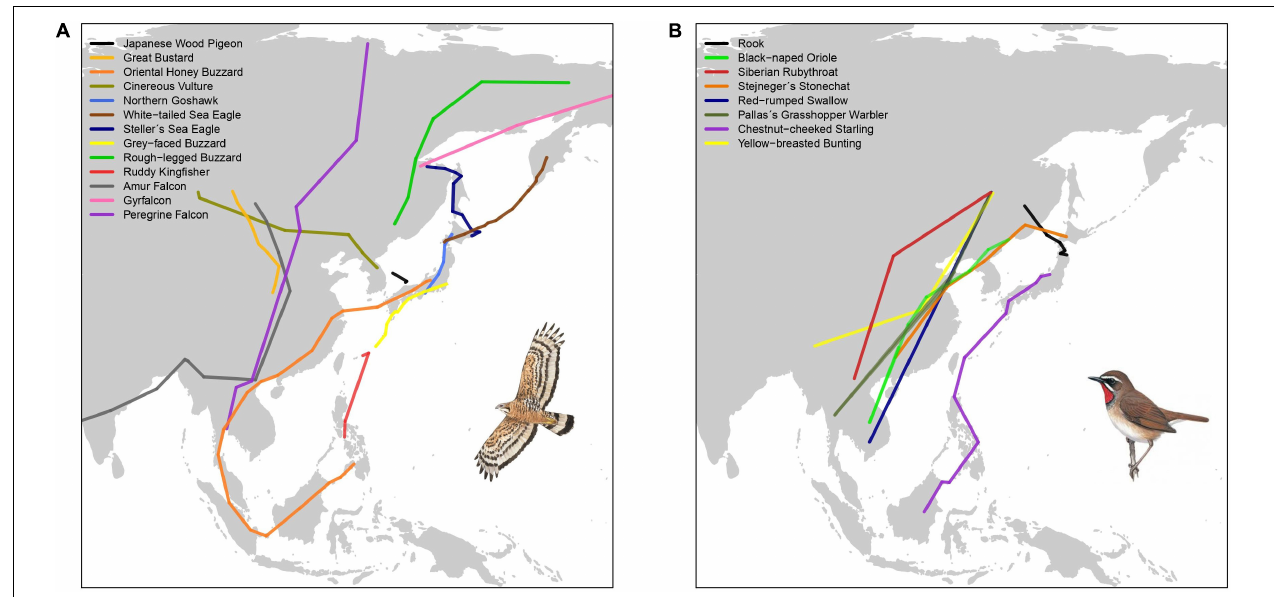
FIGURE 2 | Autumn migration routes of landbirds in the EAF, including one individual track for each all species for which published data is available ( n = 21). (A) Non-passerines (illustration of Oriental honey buzzard Pernis ptilorhynchus ), (B) Passerines (illustration of Siberian rubythroat Calliope calliope ). Based on Ueta et al. (1998, 2000), Higuchi et al. (2005), Shiu et al. (2006), Kim et al. (2007), Kudo (2008), McIntyre et al. (2009), Dixon et al. (2011, 2012), Kessler et al. (2013), Takagi et al. (2014), Koike et al. (2016), Yamaura et al. (2017), Yamaguchi et al. (2017), Heim et al. (2018a, 2020), Choi et al. (2019), and Uemura et al. (2020). Bird illustrations reproduced with permission of Lynx Edicions/Handbook of the Birds of the